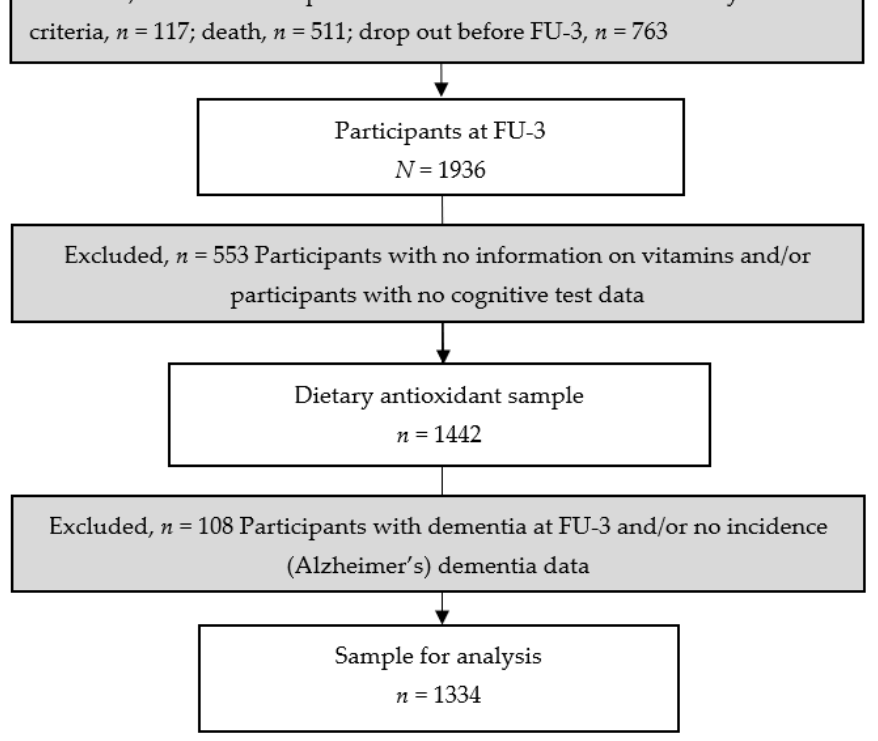
Figure 1. Flow chart of participants included in the analyses. Abbreviations: AgeCoDe, German Study on Ageing, Cognition and Dementia in Primary Care Patients; n, number; FU, follow up.